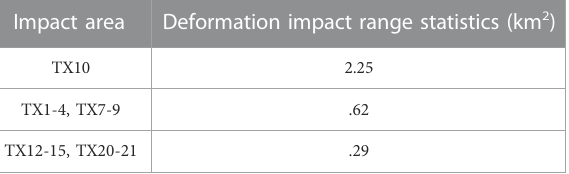
TABLE 5 Deformation zone impact area statistics.